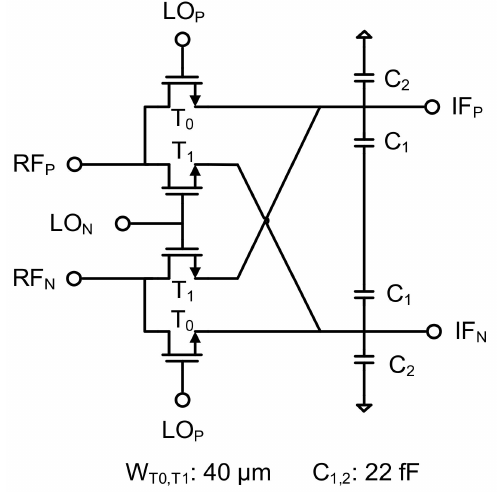
Figure 6. Schematic of 60 GHz double-balanced passive